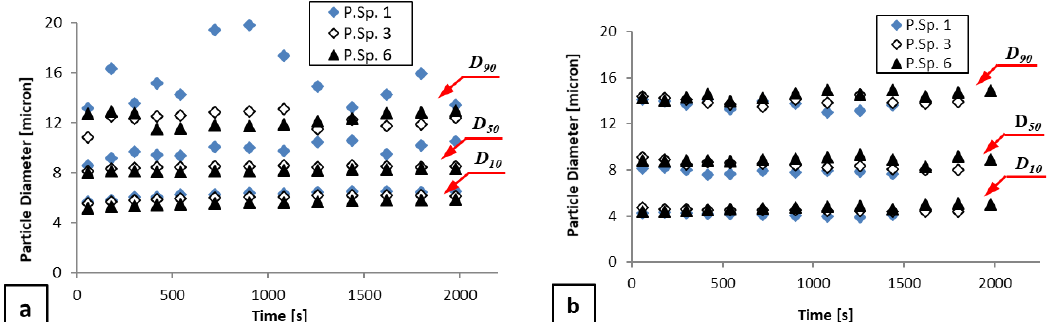
Figure 2. Particle diameter variation (D 10 , D 50 and D 90 ) over time for three different shear conditions (P.Sp.) 1, 3 and 6 rpm, during analysis by laser diffraction using Horiba LA-920 for ( a ) talc and ( b ) calcium carbonate, based on volume distribution.